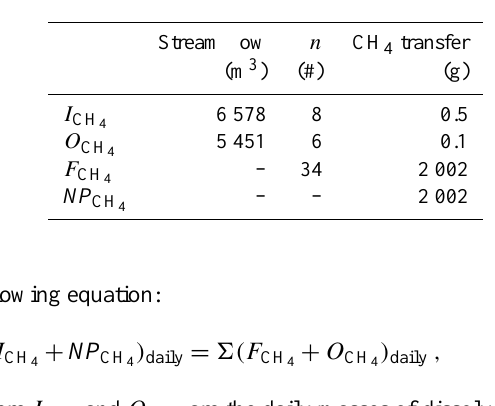
Table 3. Wetland mass balance (Eq. 2) of CH 4 for the 2012 growing season (3 July to 5 August), including stream input ( I CH ) and out- 4 put ( O CH ), flux of CH4 ( F CH ) from the EC tower, and estimate 4 4 of net CH 4 production within wetland soil ( NP CH ). 4